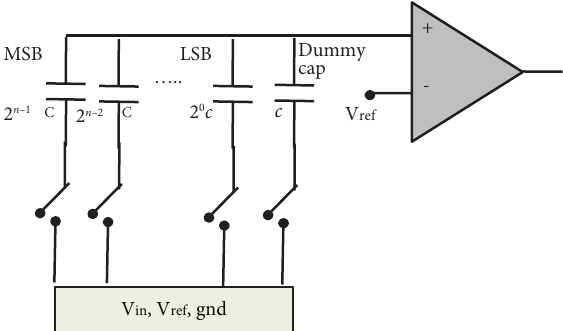
Figure 8: Te conventional capacitive DAC.